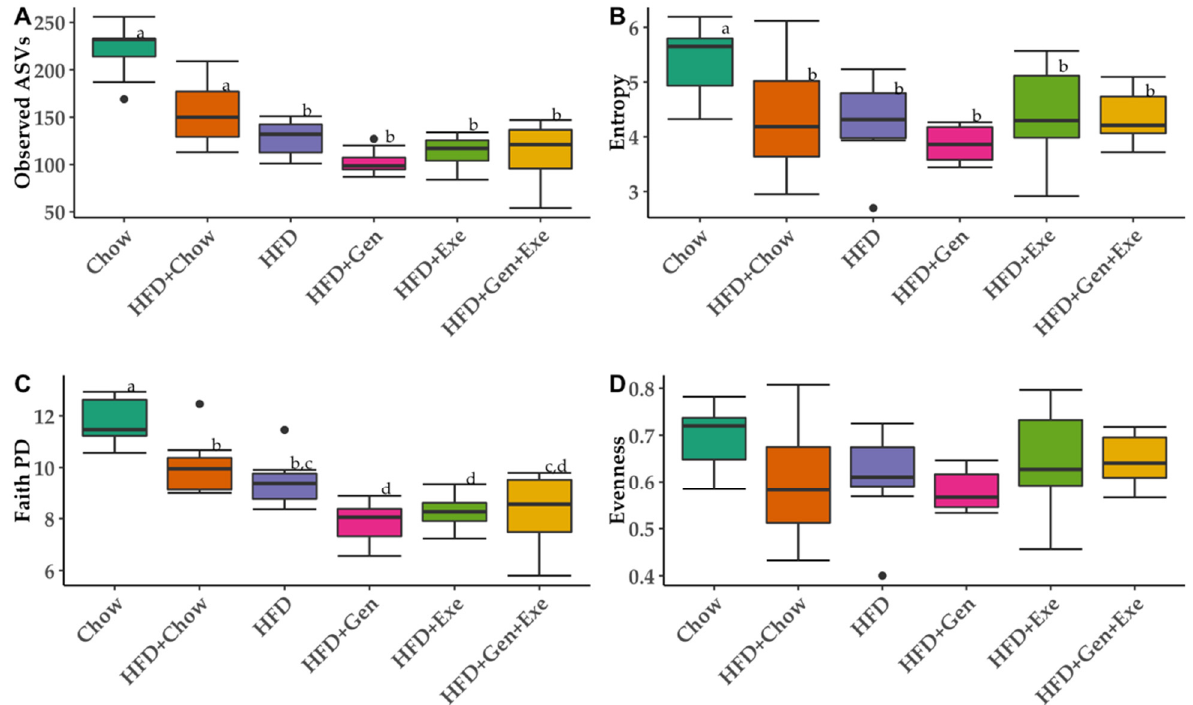
Figure 4. Microbial alpha-diversity (within-group diversity) after 24 weeks of six different dietary and exercise interventions using ( A ) observed amplicon sequence variants (ASVs; bacterial richness), ( B ) Shannon diversity index (entropy; microbial abundance and evenness), ( C ) Faith Phylogenetic diversity index (Faith PD) and ( D ) Pileous Evenness index (evenness) values. Treatment groups are as follows: unpurified diet (chow); high-fat, high-sugar diet (HFD + chow); HFD; HFD + exercise (HFD + Exe); HFD + genistein (HFD + Gen); HFD + Exe + Gen. Significant group differences ( p < 0.05) by Kruskal–Wallis test after Benjamini–Hochberg correction for multiple comparisons. Different letter denotes significant differences.